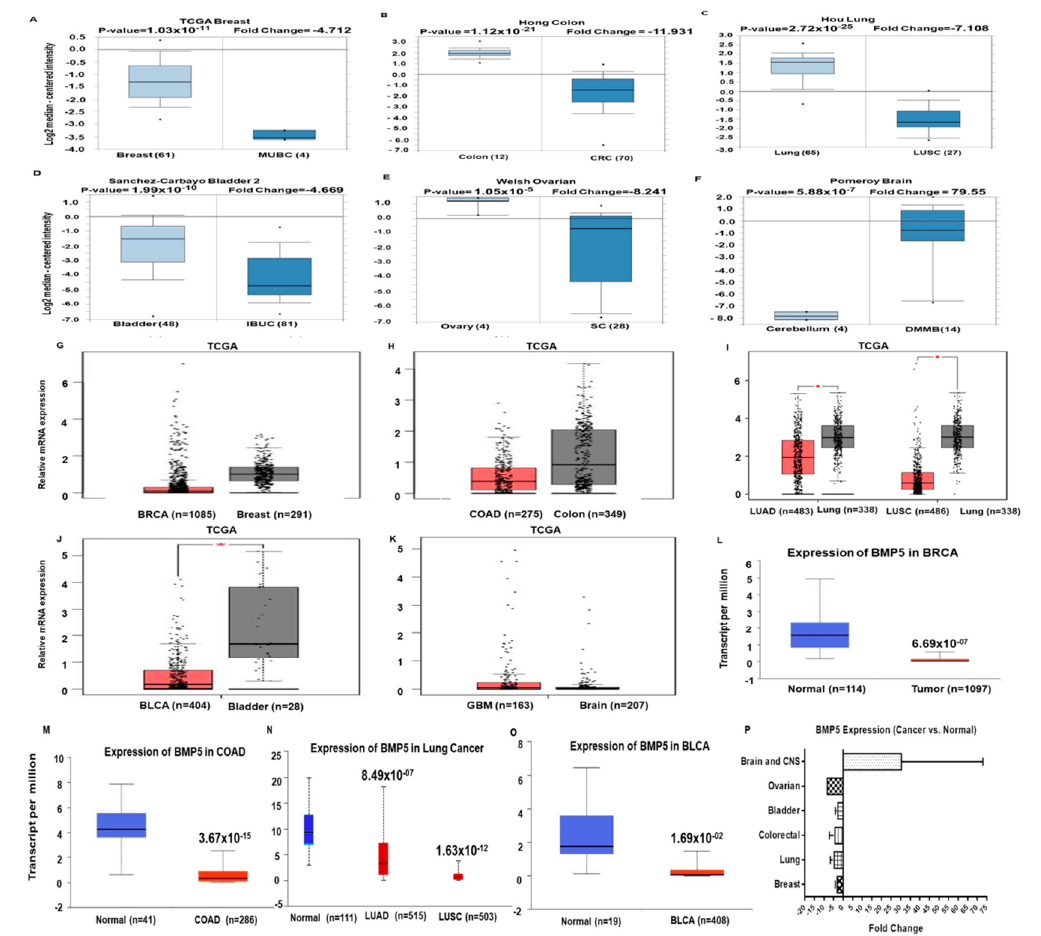
Figure 2. Expression pattern of BMP5 was compared between cancer and tissue. ( A – F ) Fold-change of BMP5 in six types of cancers was obtained from our analyses, shown as a box plot. The box plot comparing specific BMP5 expression in normal (left plot) and cancer tissue (right plot) was derived from the ONCOMINE database. The above and below asterisk of the box represent maximum and minimum value, respectively. ( G – K ) BMP5 expression data obtained from the TCGA database through GEPIA. The expression of BMP5 in lung adenocarcinoma (LUAD) and lung squamous cell carcinoma (LUSC) were compared and profiled against normal lung tissue samples (see I ). ( L – O ) BMP5 gene expression in TCGA database. Box plots exhibiting the BMP5 mRNA expression in the primary tumor (red plot), respectively and their normal (blue plot) tissues, using data from the TCGA database through UALCAN. *: p < 0.01. ( P ) The fold-change of BMP5 in various types of cancers were compared in our analyses, as shown in Supplementary Table S1 and expressed as a bar plot.